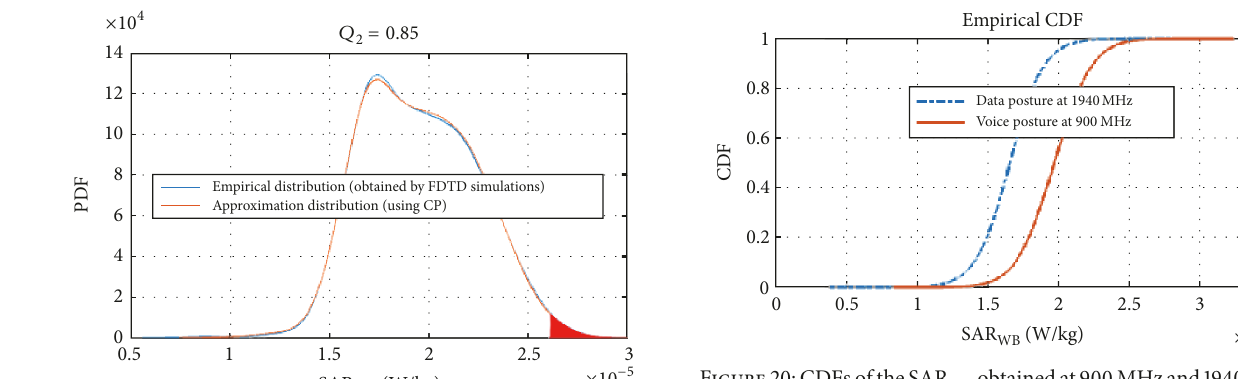
Figure20:CDFsoftheSAR obtainedat900 MHzand1940 MHz. WB